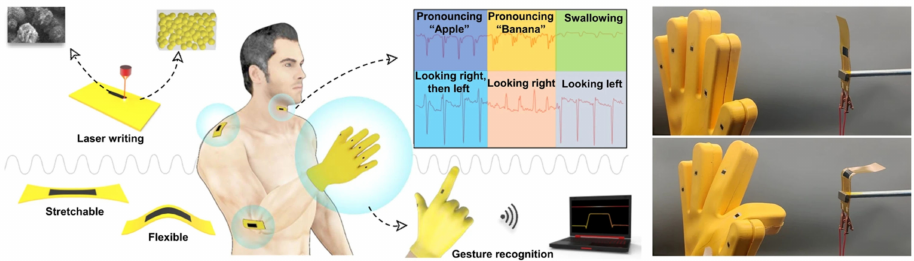
Figure 16. The LIG-based soft and stretchable electronics for gesture HCI system. Reproduced with permission from [30]. Copyright 2022 Springer